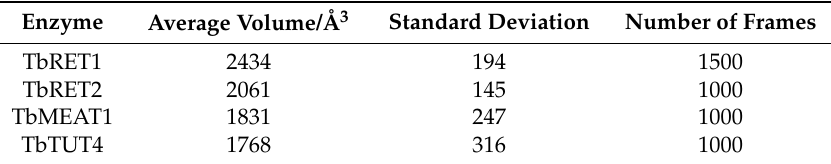
Table 2. The average pocket volume and its standard deviation over the specified number of frames for each enzyme. Enzyme Average Volume/Å 3 Standard Deviation Number of Frames TbRET1 2434 194 1831 1768 316